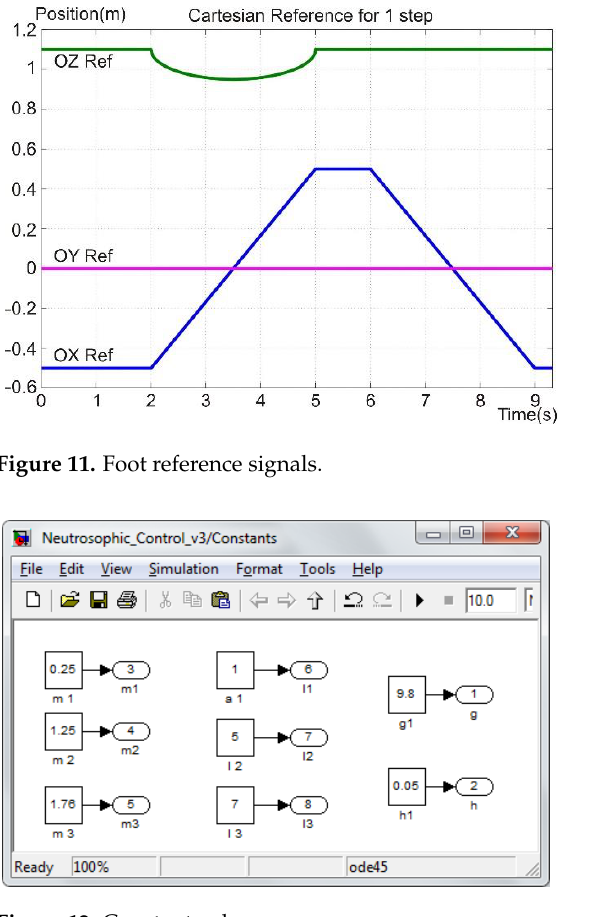
Figure 12. Constant values.